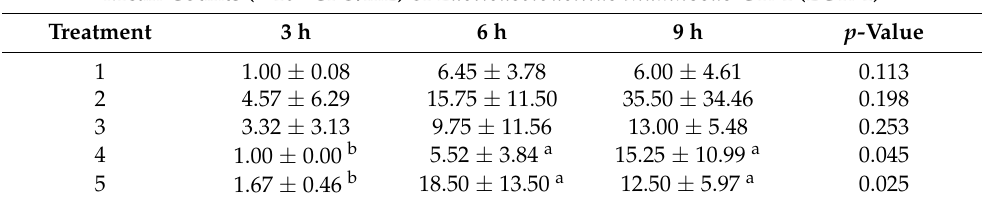
Table 1. Viable counts (mean ± SD) of LGR-1 in probiotic almond beverage supplemented with short-chain inulin and long-chain inulin following 3, 6, and 9 h of fermentation.